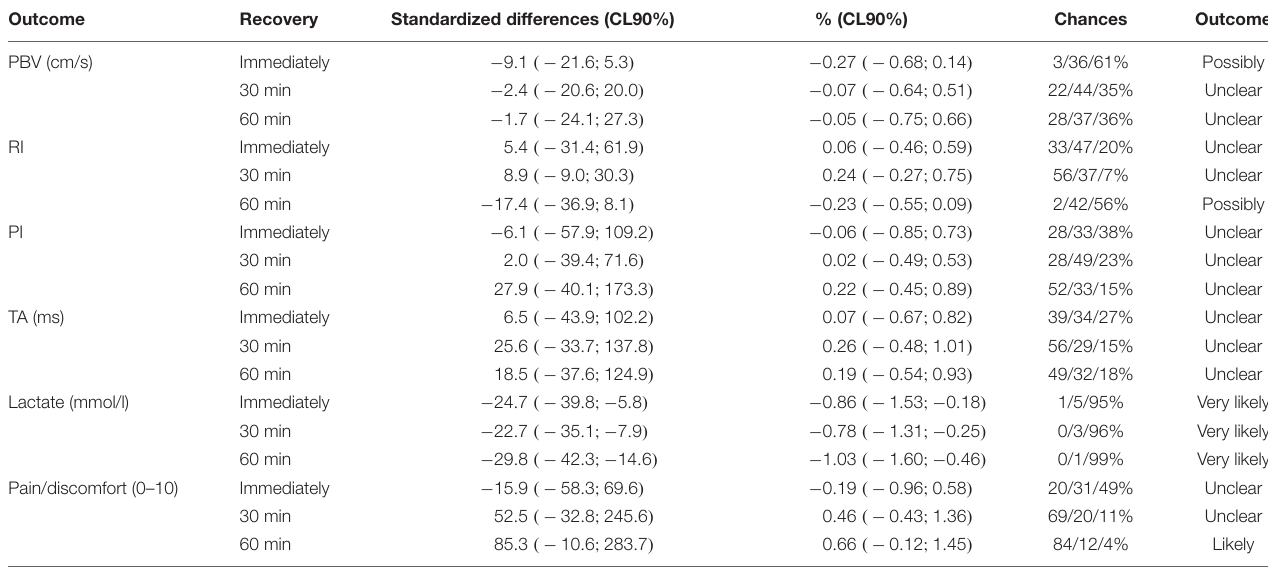
TABLE 2 | Between-group analysis during the WB-EMS and active recovery intervention on vascular function and lactate removal. Outcome Recovery Standardized differences (CL90%) % (CL90%) Chances